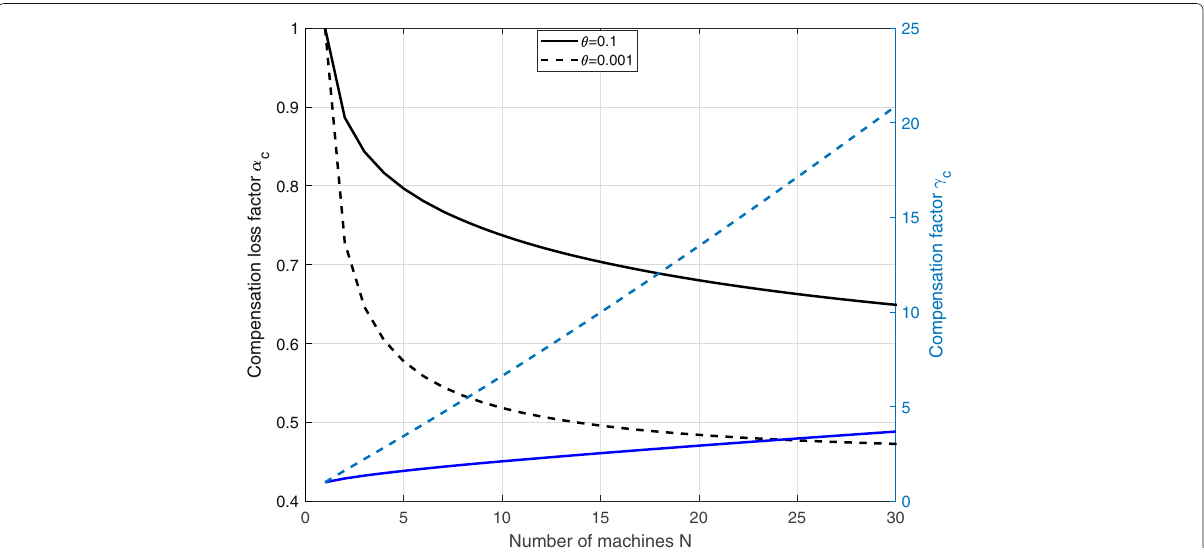
Fig. 5 Power-controlled compensation loss and compensation factors. Compensation loss factor α c and compensation factor γ c as a function of the number of nodes N , for distinct QoS exponents